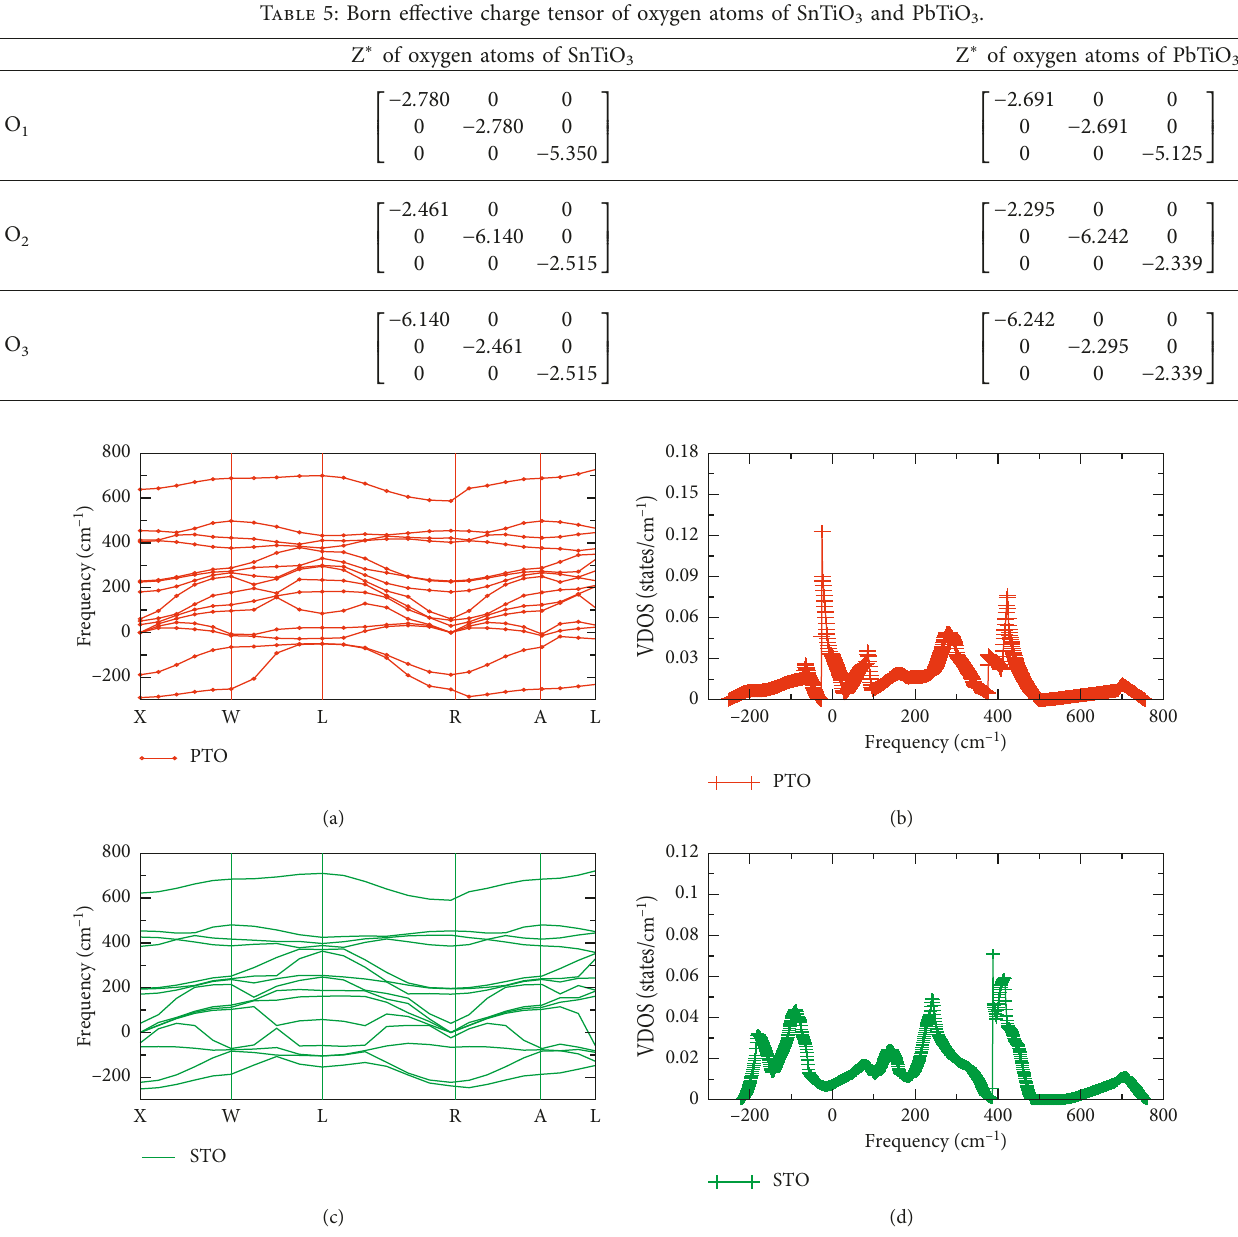
Figure 9: Phonon dispersion and vibrational density of states of SnTiO